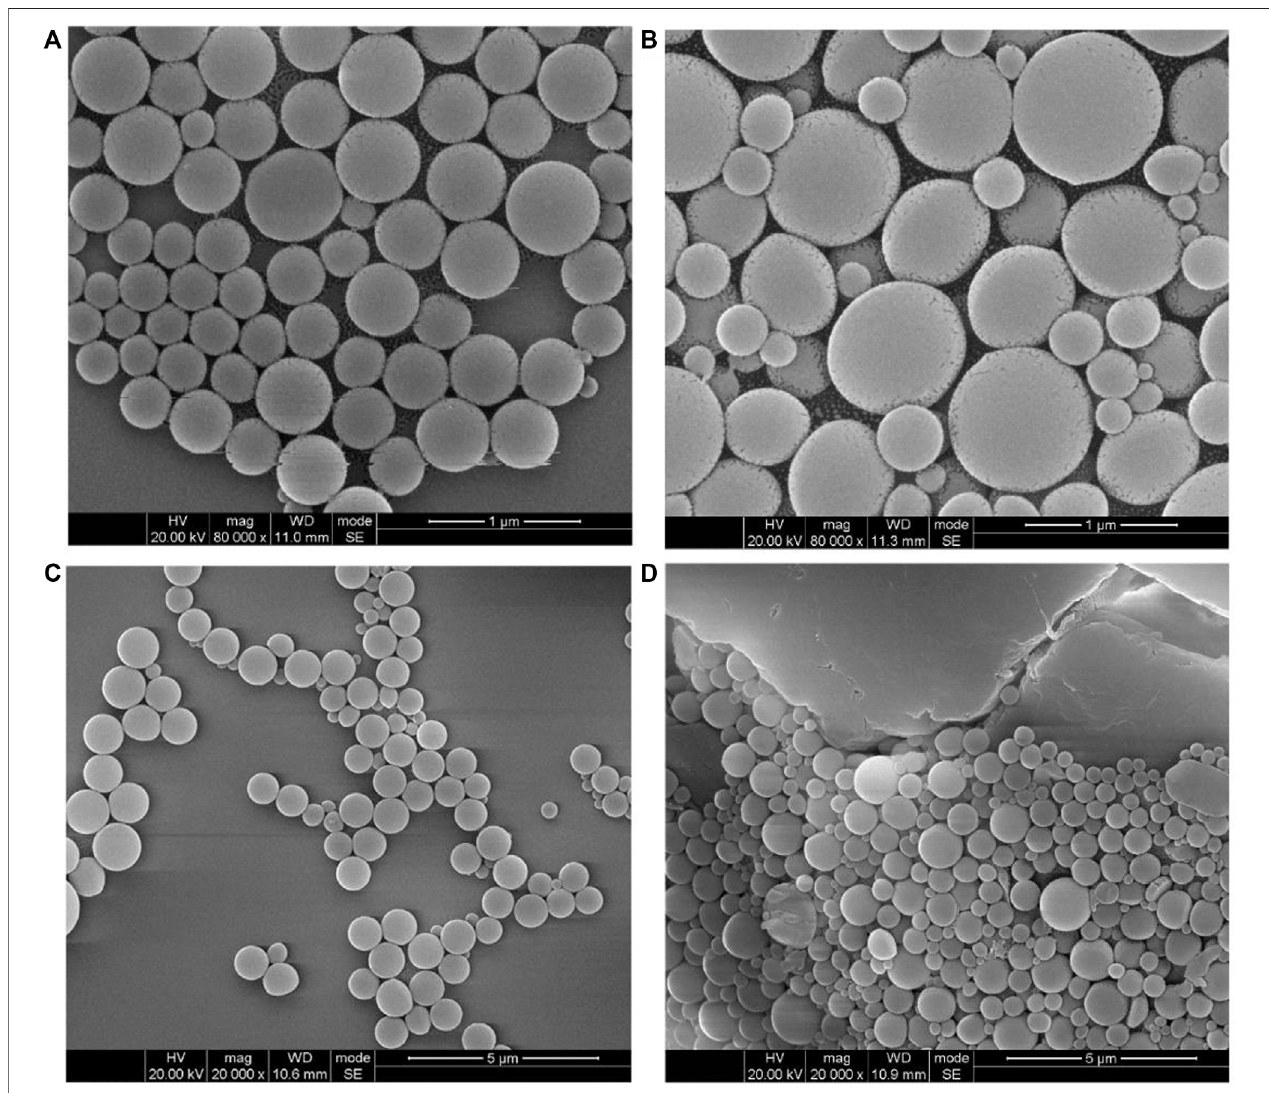
FIGURE 7 | The SEM morphology of QD-embedded polymeric hybrid particles using pristine PAE-NC (A) , hydrolyzed PAE-NC-H1 (B) , hydrolyzed PAE-NC- H4 (C) , and PAE-NC-H8 (D) , respectively.